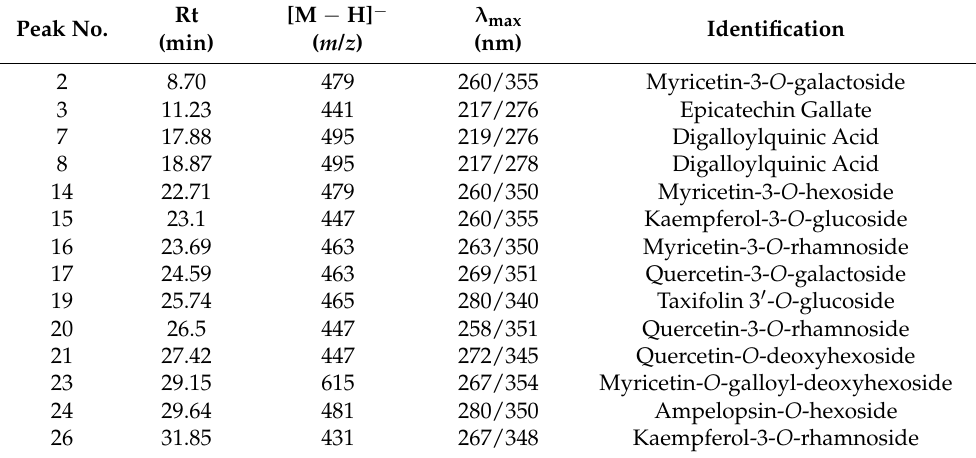
Table 3. Peaks assignment of ethyl acetate extract (EAE) of P. lentiscus L. distilled leaves, acquired by HPLC-MS (peak numbers have been recorded in Figure 1). Peak